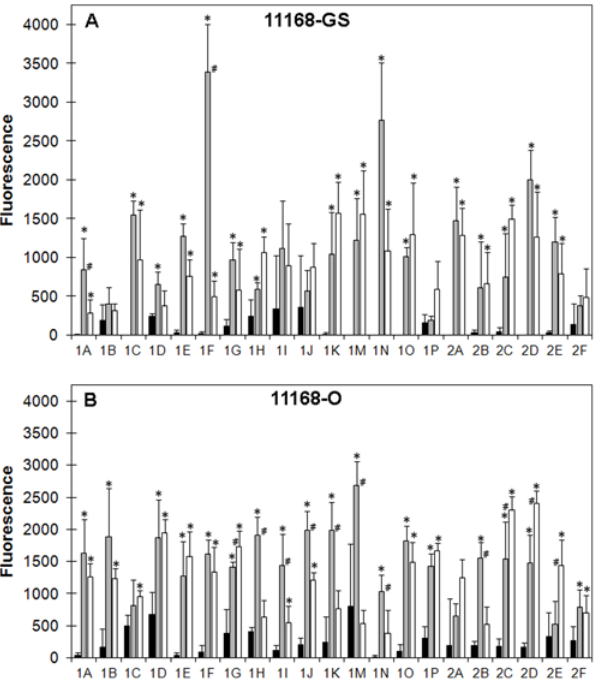
Figure 1. Binding of C.jejuni 11168 to uncapped terminal Gal structures. Fluorescence intensities associated with C. jejuni 11168-GS (A) and C. jejuni 11168-O (B) binding to uncapped Gal structures (25 u C, black bar; 37 u C, grey bar; and 42 u C, white bar). For the structure of the individual glycans refer to Table 2. * Significantly different to 25 u C, P , 0.05; # Significant difference between 37 u C and 42 u C, P ,